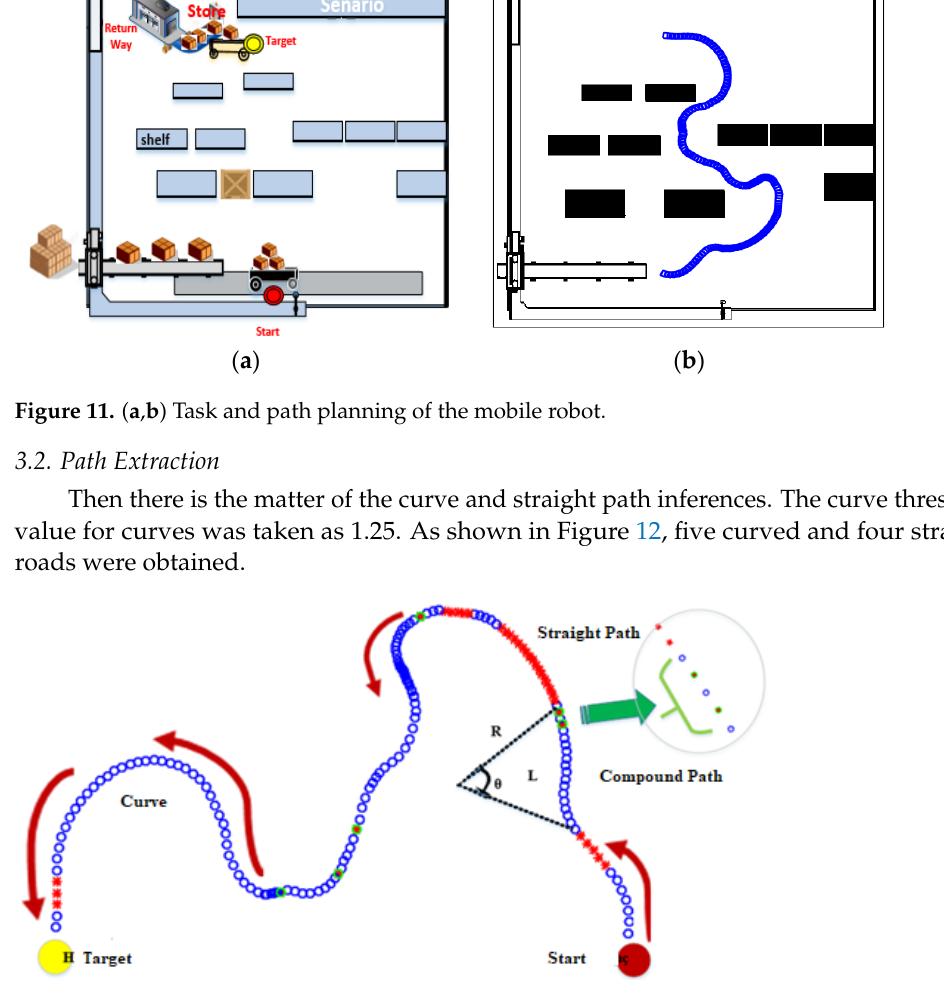
15 of 21 Figure 10. Speed acceleration application motion and operations.